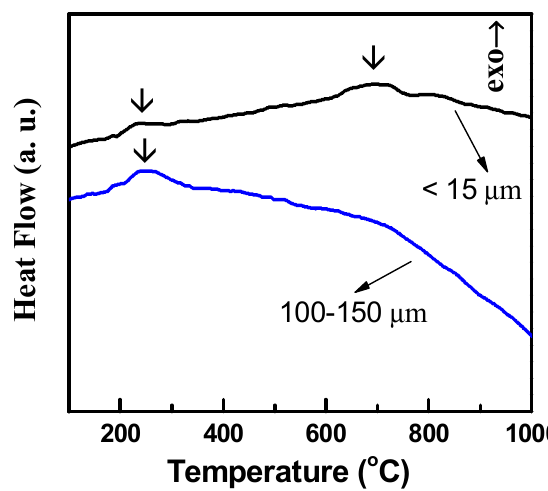
Figure 3. DSC (differential scanning calorimetry) curves of the as-atomized high-Nb TiAl powders with different sizes.